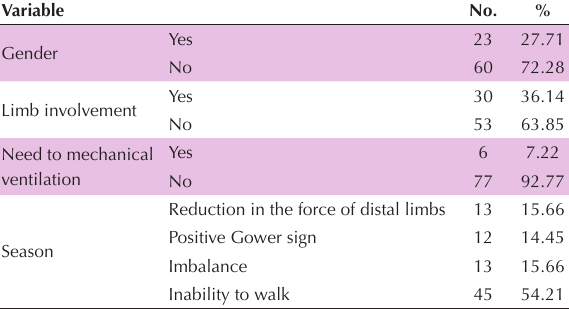
Table 2. Frequency distribution of clinical symptoms of the studied patients